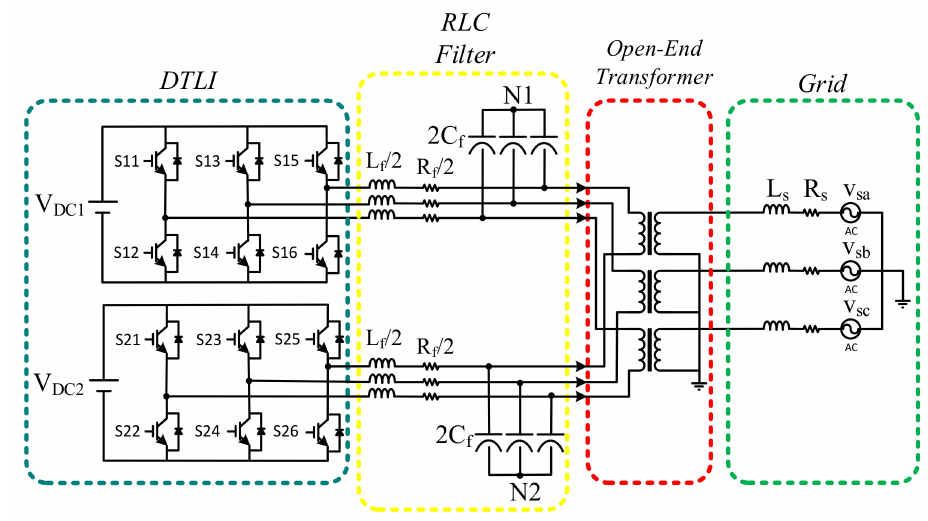
Figure 2. DTL VSI topology with the individual capacitor type (ICT) filter.